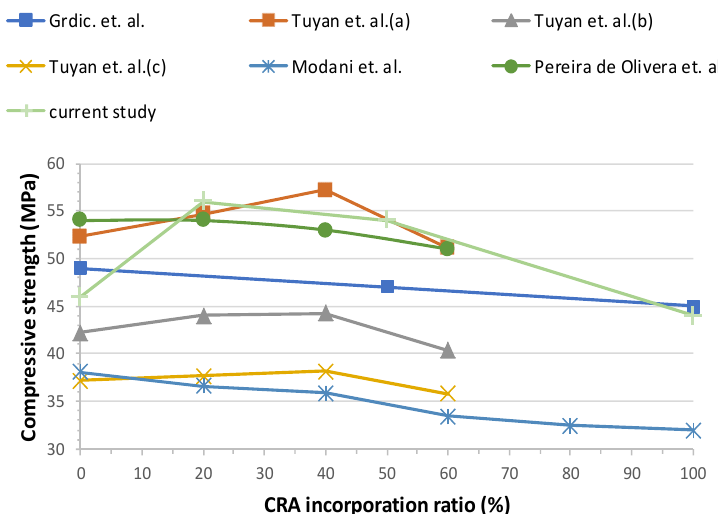
Figure 14. 28-day compressive strength results overview.